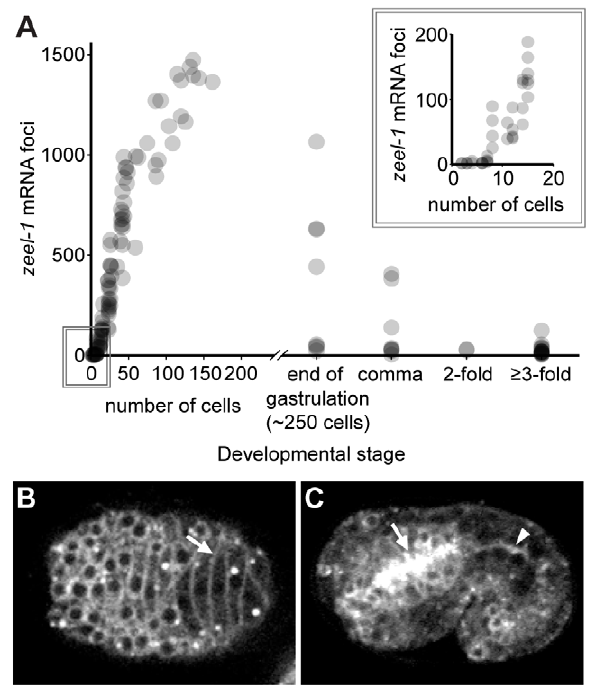
Figure 6. zeel-1 is transiently expressed during embryogenesis and localizes to cell membranes. (A) zeel-1 mRNAs were quantified in wild-type embryos via single-molecule fluorescence in situ hybrid- ization [56]. Embryos were staged by counting nuclei manually (1- to 40-cell embryos), counting nuclei using image analysis software (41- to 200-cell embryos), or classifying embryos as end of gastrulation ( , 250 cells), comma, 2-fold, or $ 3-fold. Inset shows a magnification of the boxed area. Each circle represents an independent embryo. n =130. (B– C) Embryos expressing ZEEL-1::GFP . Panel in (B) shows a dorsal view during intercalation of epidermal cells. Arrow indicates an epidermal cell membrane. Panel in (C) shows a lateral cross-section of a 1.5-fold embryo. The apical face of the pharynx (arrow) and the intestine (arrowhead) are indicated.